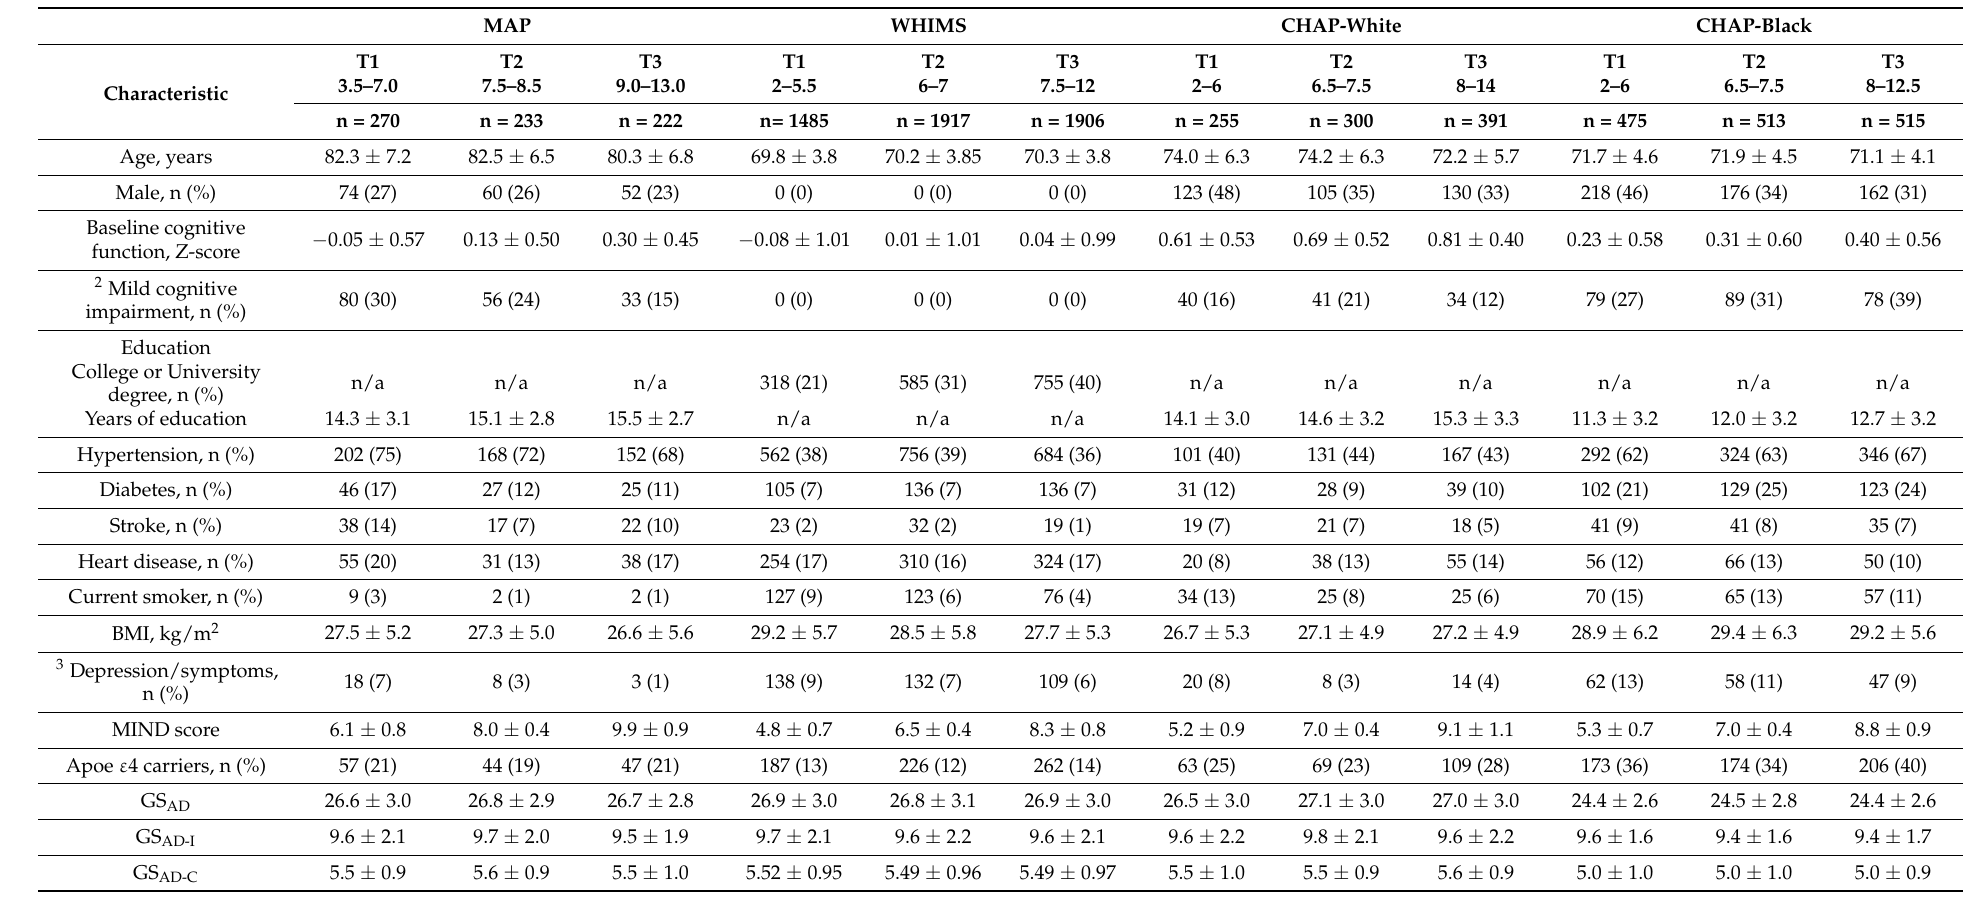
Table 1. Baseline characteristics of participants by tertiles of MIND score 1